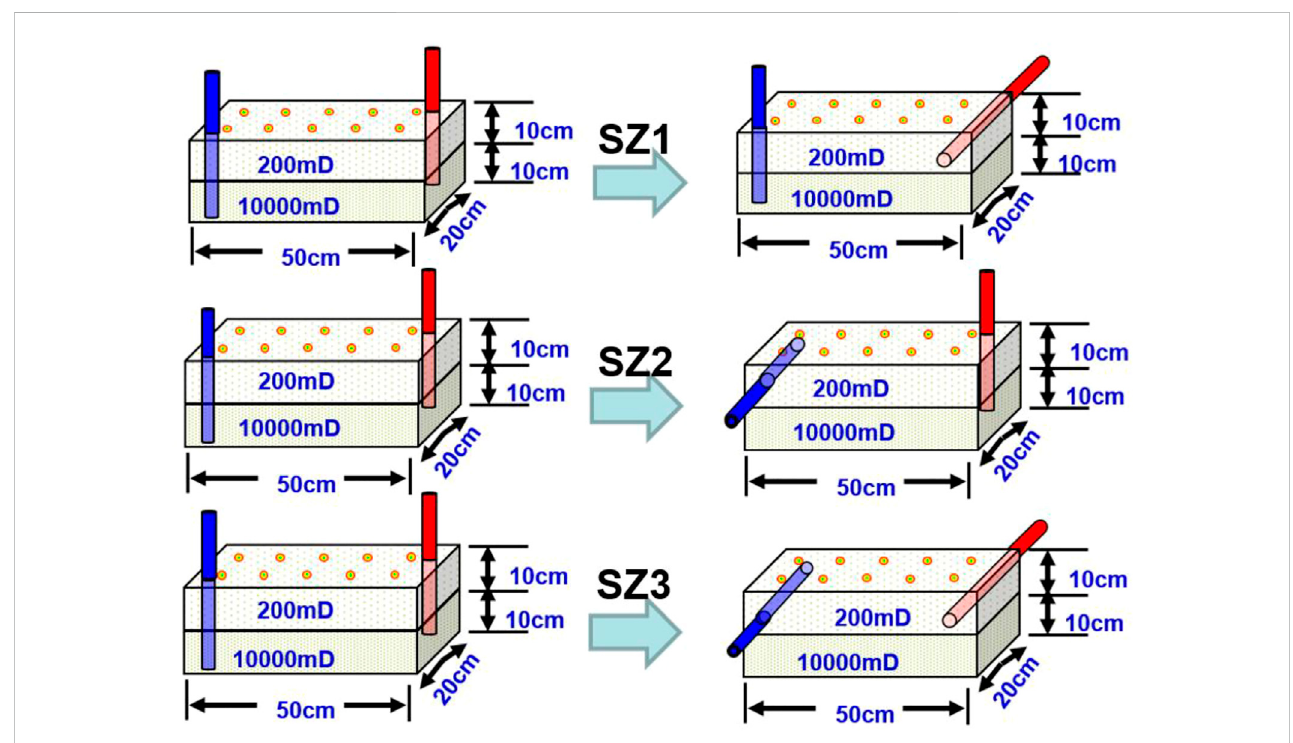
FIGURE 3 Three large-scale physical models for mechanism study on development adjustment strategy of heterogeneous thick reservoir.